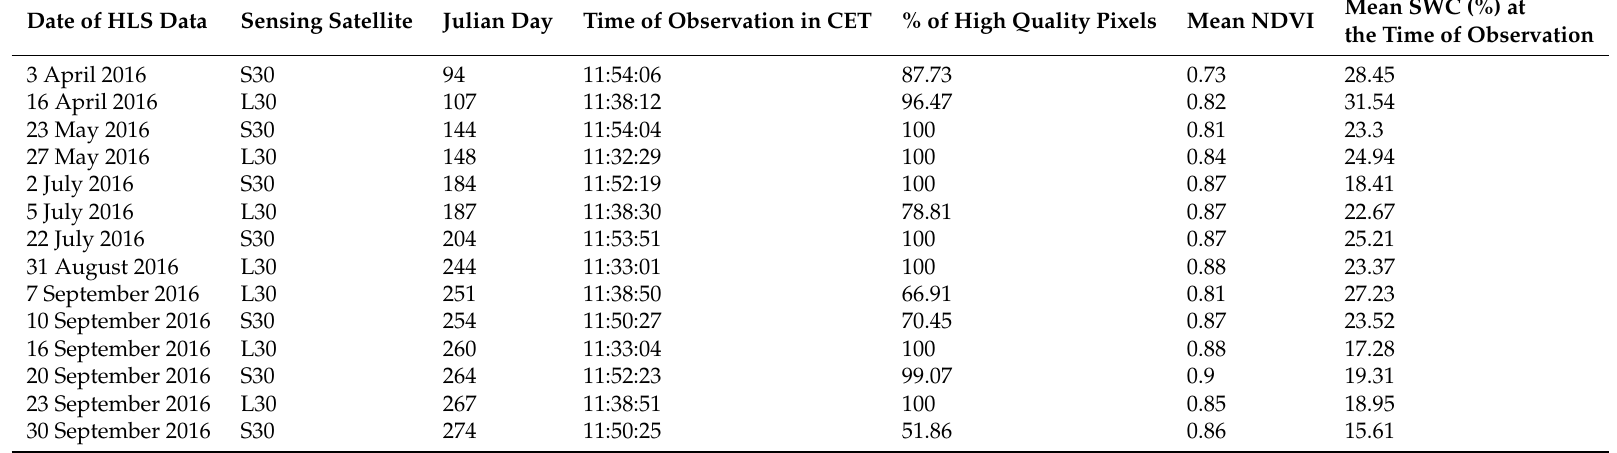
Table 3. Overview of the harmonized Landsat-8 and Sentinel-2 (HLS) data used in this study, with the percentage of high-quality pixels and mean NDVI within the target area defined by flux footprint (delineated in Figure 1). CET: Central European time, NDVI: Normalized difference vegetation index, L30: Landsat-8 data, S30: Sentinel-2 data, SWC: soil water